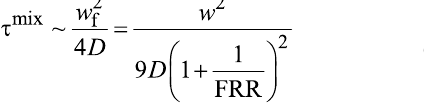
aqueous phase, which prevents particle interaction (this was